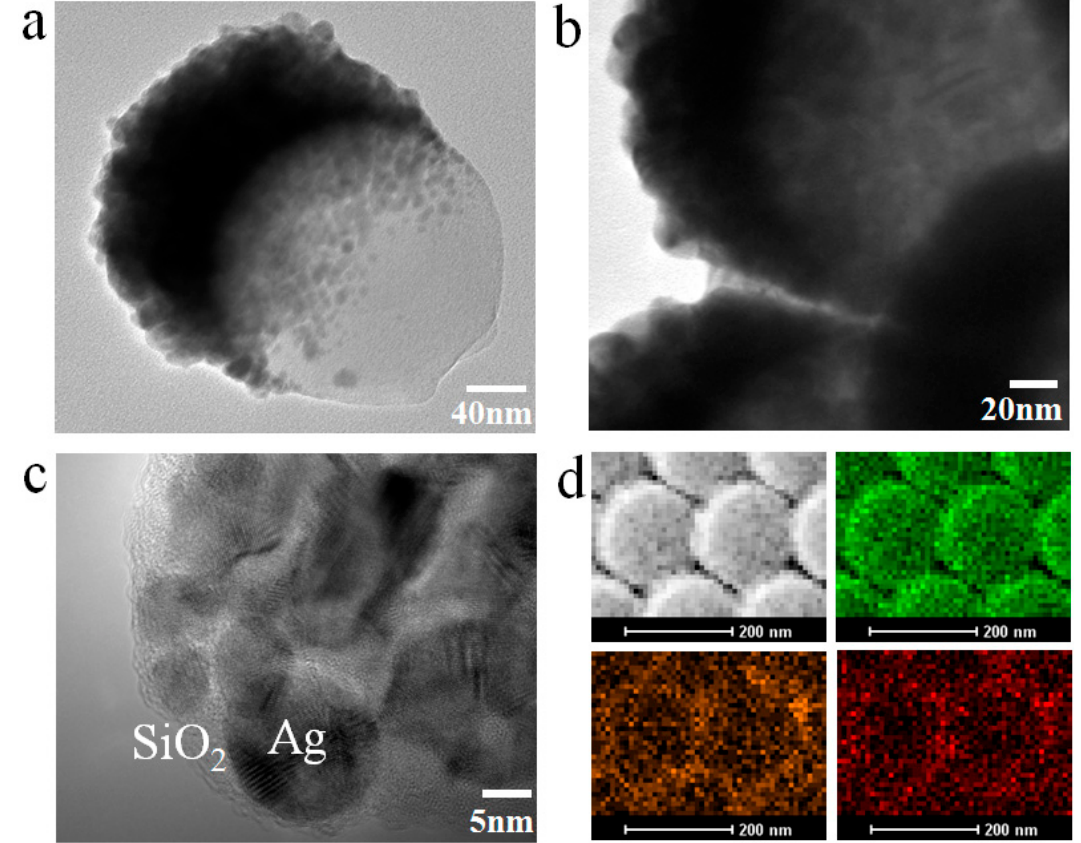
Figure 3. ( a – d ) TEM, HRTEM, and element analysis images of the SiO 2 − Ag nanocap. Reproduced with with permission from [9] American Chemical Society, permission from [9] American Chemical Society, 2014.